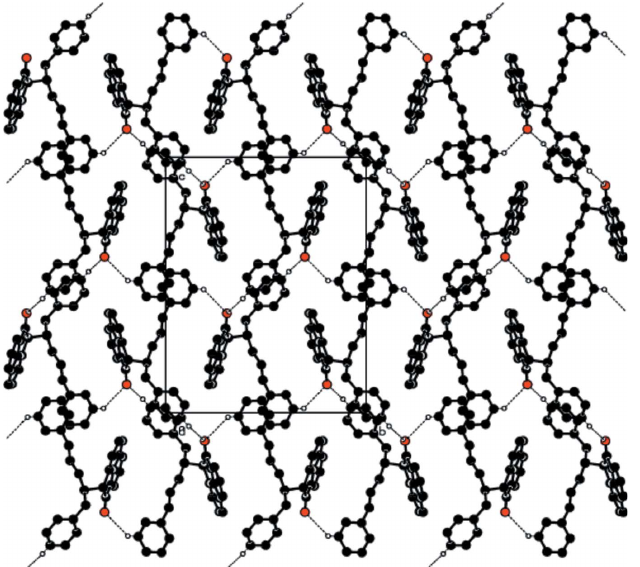
Figure 7 Aview of the crystal structure of (II) showing the R 2 Dashed lines indicate weak C—H (cid:2)(cid:2)(cid:2) O intermolecular interactions. H atoms not interactions have been omitted for clarity.